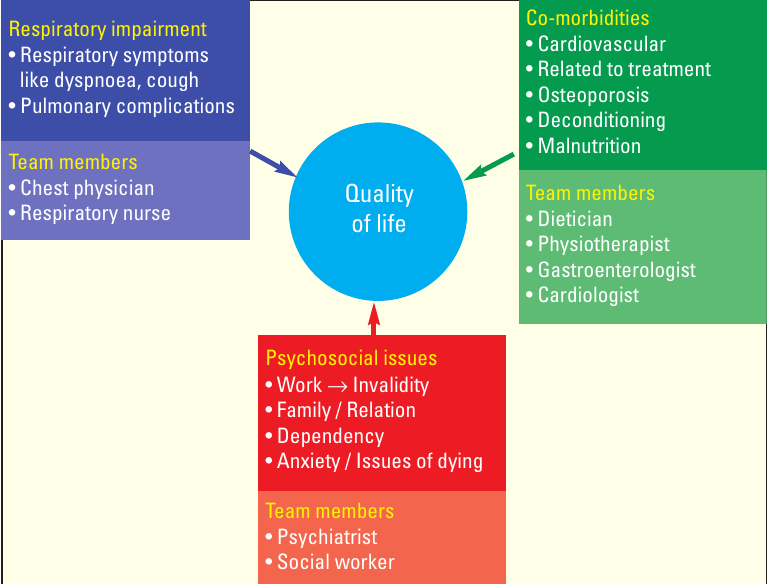
The multidisciplinary care team for ad- vanced lung